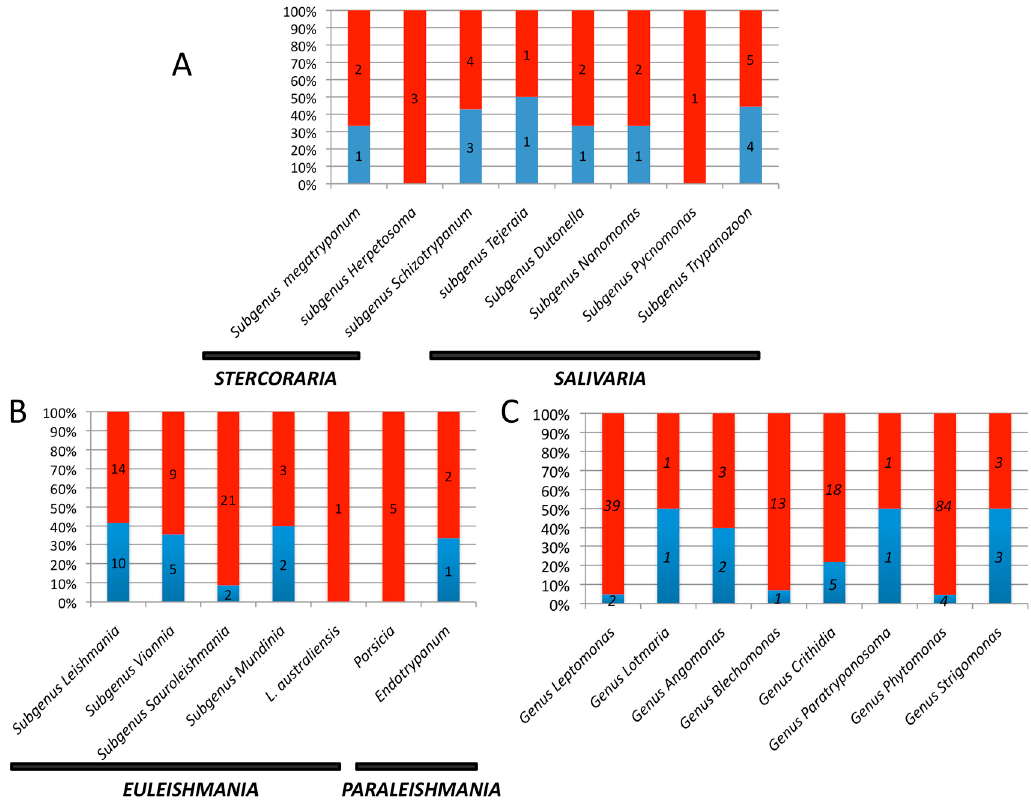
Figure 1. Proportion of available genomes (in blue) on the number of currently named species (in red) for the various genera belonging to the Trypanosomatidae family. ( A ) genus Trypanosoma ; ( B ) genus Leishmania ; ( C ) other Trypanosomatidae genera.